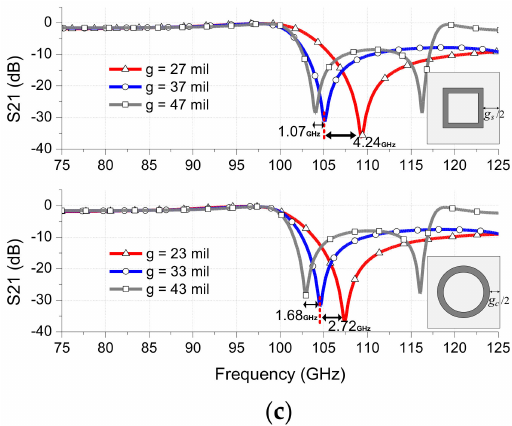
Figure 6. Influence of the design parameters on the FSS frequency response: ( a ) loop length “ d ,” ( b ) unit cell period “ p ,” ( c ) gap between the loops “ g